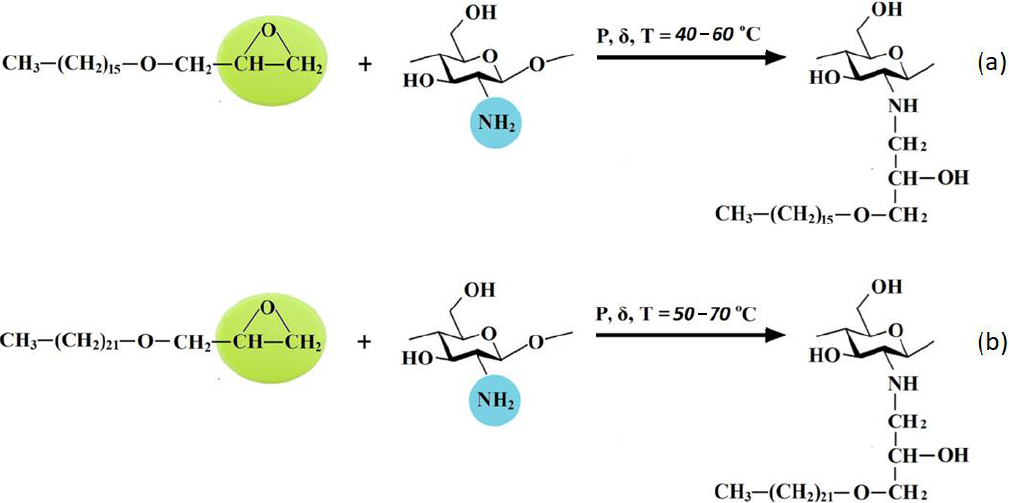
Figure 7. The proposed schemes of chitosan hydrophobization using hexadecylglycidyl ( a ) and docosylglycidyl ( b ) ethers as alkylation agents.